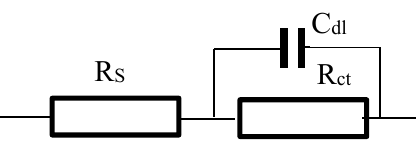
Figure 11. Cell equivalent circuit model [7, 19, 39].